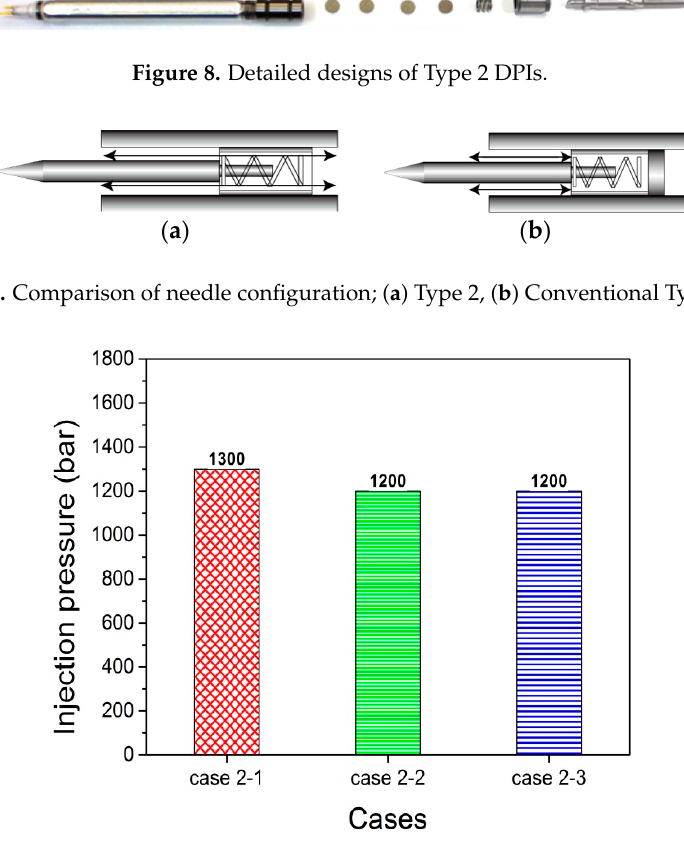
Figure 10. Comparison of the maximum injection pressure of Type 2 DPIs.